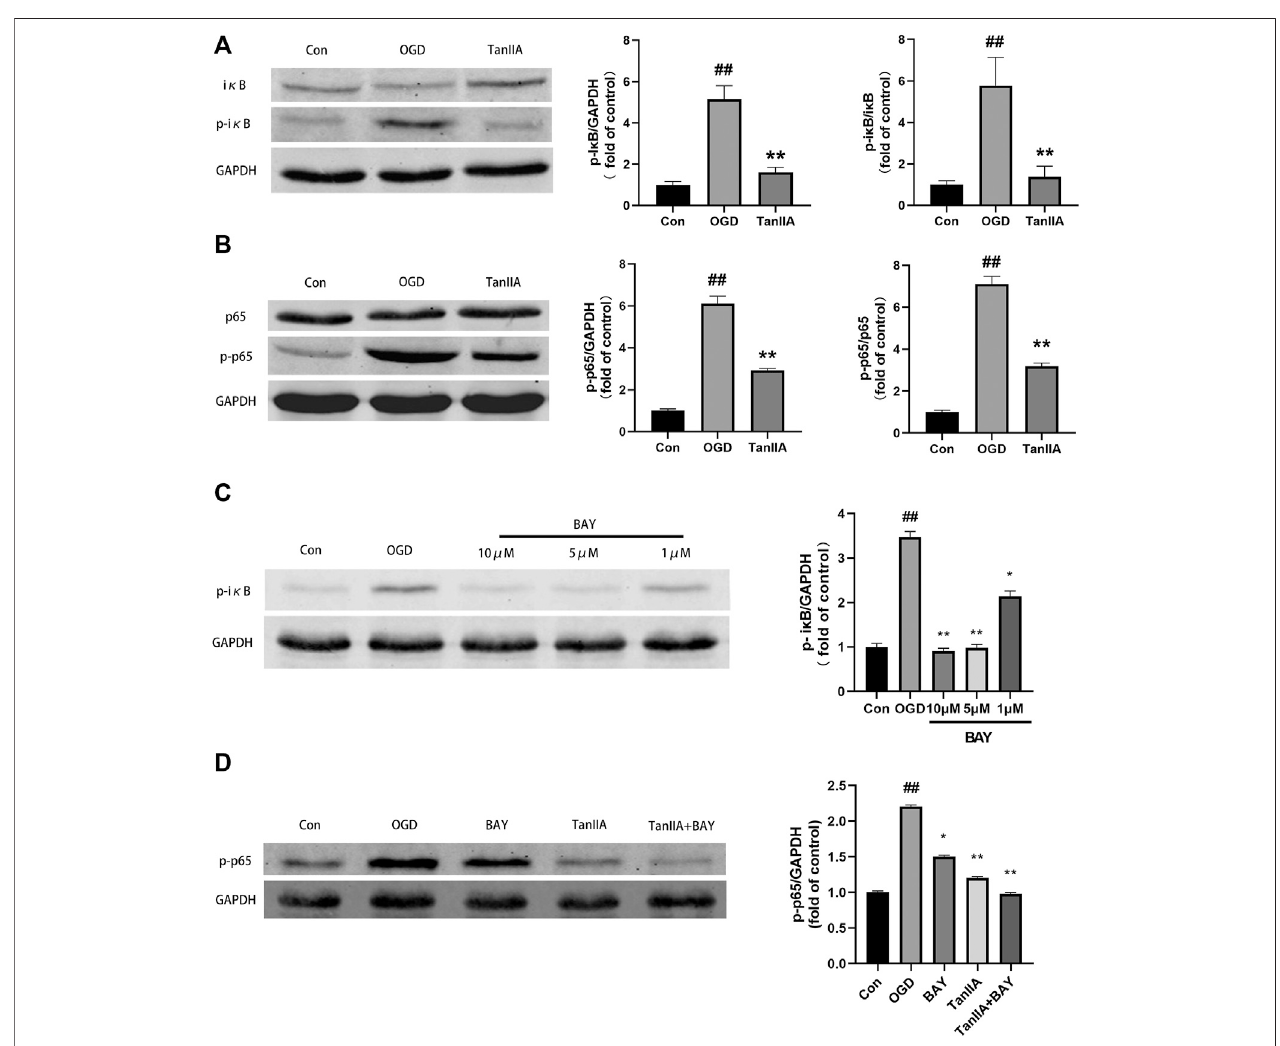
FIGURE 7 | Tanshinone IIA regulated NF- κ B signaling pathway in BV2 cells after oxygen-glucose deprivation (OGD). (A) The protein level of p-I κ B in BV2 cells treated with Tanshinone IIA. (B) The protein level of p-p65 in BV2 cells treated with TanshinoneIIA. (C) The protein level of p-I κ B in BV2 cells treated with BAY-11-7082. (D) Theproteinlevelofp-p65inBV2cellstreatedwithTanshinoneIIAandBAY-11 – 7082.## p < 0.01,comparedwiththecontrolgroup.* p < 0.05,** p < 0.01,compared with the OGD group. Con, control group; OGD, oxygen-glucose deprivation; TanIIA, Tanshinone IIA; BAY, BAY-11-7082, a NF- κ B inhibitor, n (cid:1)